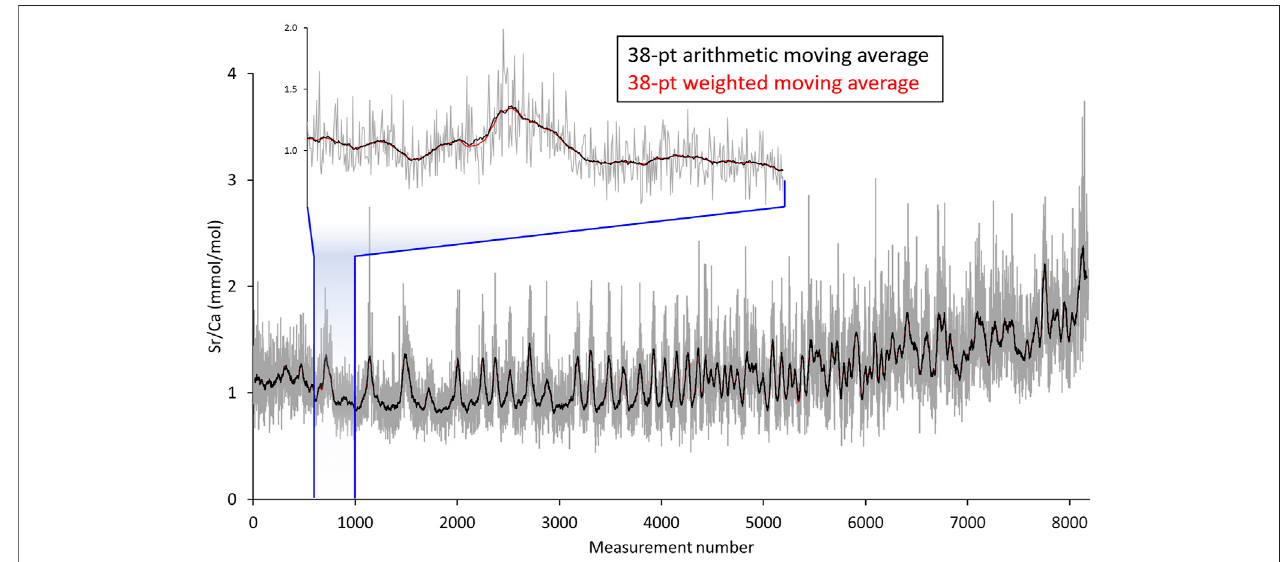
FIGURE 1 | LA-ICP-MS line scan data (here molar Sr/Ca ratios, grey) of the hinge portion of Arctica islandica specimen ICE120703AL2 from NE Iceland ( Table 1 ). Directionofgrowth istotheright. Signals extracted via a38-pt arithmetic moving averageslightlydeviate fromsuch obtained witha38-ptweightedmoving averagethat takes the circular geometry of the laser beam into account. The arithmetic average (black) preserves more noise than the weighted average (red).